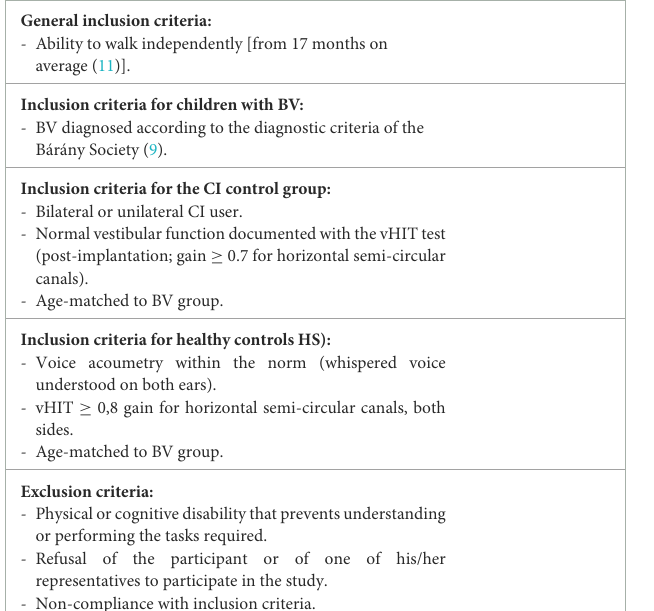
TABLE 2 Inclusion and exclusion criteria for the study participants.